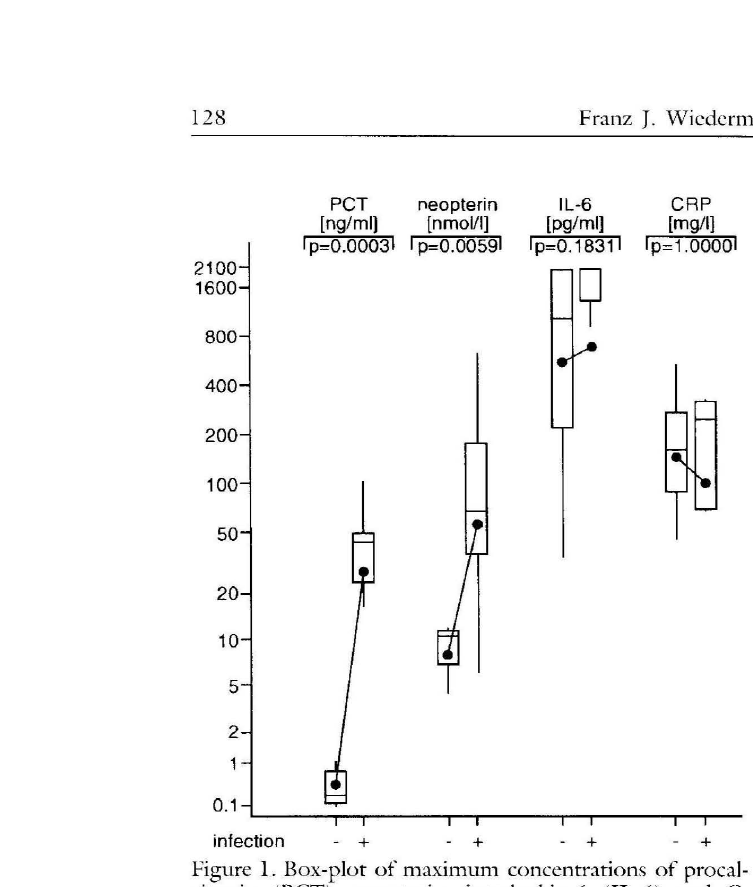
Egure 1. Box-plot of maximum concentrations of procal citonin (PCT), neopterin, interleukin-6 (IL-6) and C reactive protein (CRP) within the first 24 hours after onset of ARDS. Groups are defined by infectious and non-infectious (toxic) aetiology of the disease. PCT did not exceed concentrations of 3 ng/ml in the non-infectious group, whereas the infectious group was characterized by a mean PCT value of 45 ng/ml. The groups could not be distinguished on the basis of IL-6 and CRP, PCT and neopterin values were clearly ditlcrent in the two groups. Results are indicated as median (horizontal lines), mean (tilled dots), SEM (box) and minimum-maximum concentrations. rData from Rrunkhorst, et al. (40), figure from Meisner M (65), reproduced with permission from Brahms-Diagnostica, Berlin].